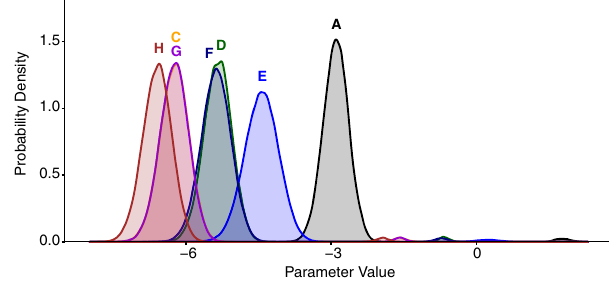
FIG. 4. The complete parameter distribution for question 19. The large labeled curves on the left side of the plot contain 99% of the results (also shown in Fig. 2), and the small bumps on the right side of the plot contain about 1% of the results (also shown in Fig. 5). A gap in the horizontal axis of about 1.5 exists between the left and right distributions for all